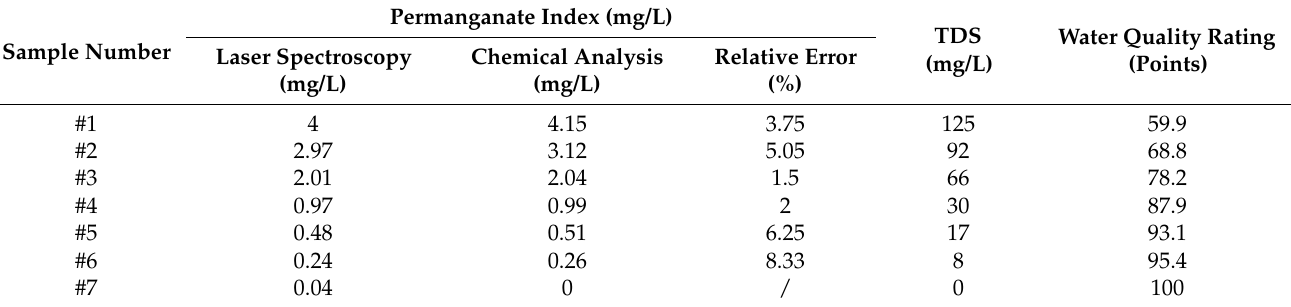
Table 2. The results of water quality measurement.